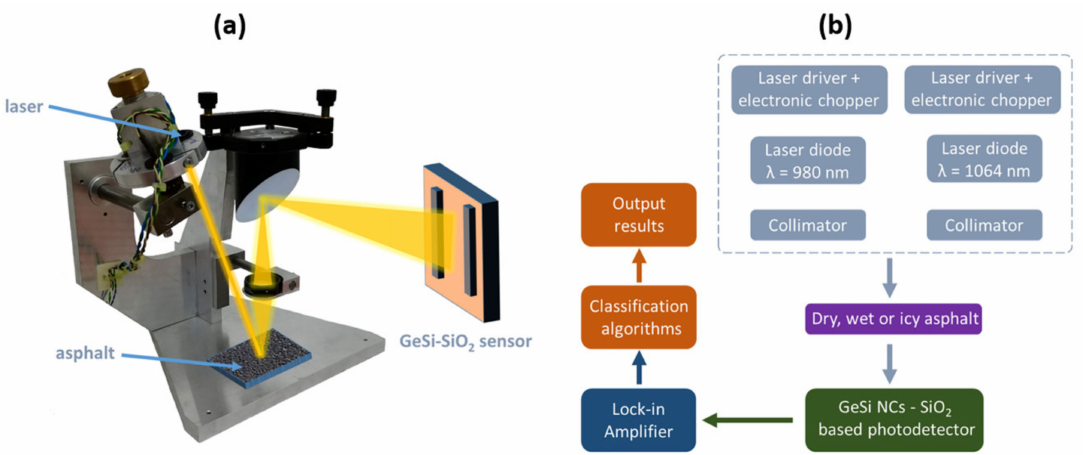
Figure 4. ( a ) The working principle and ( b ) the workflow of the sensor setup.